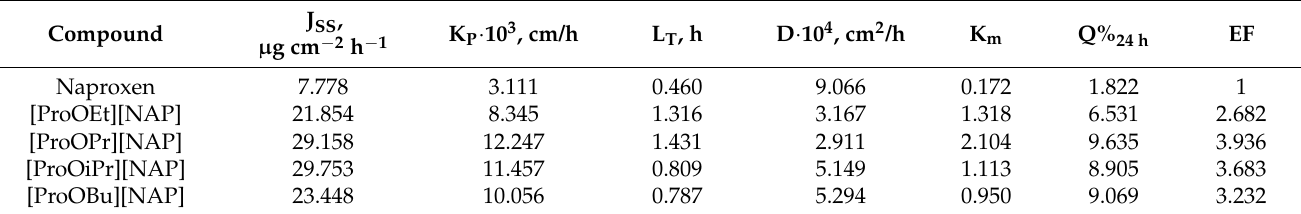
Table 9. Skin permeation parameters for naproxen and L-proline alkyl ester naproxenates; n = 3.